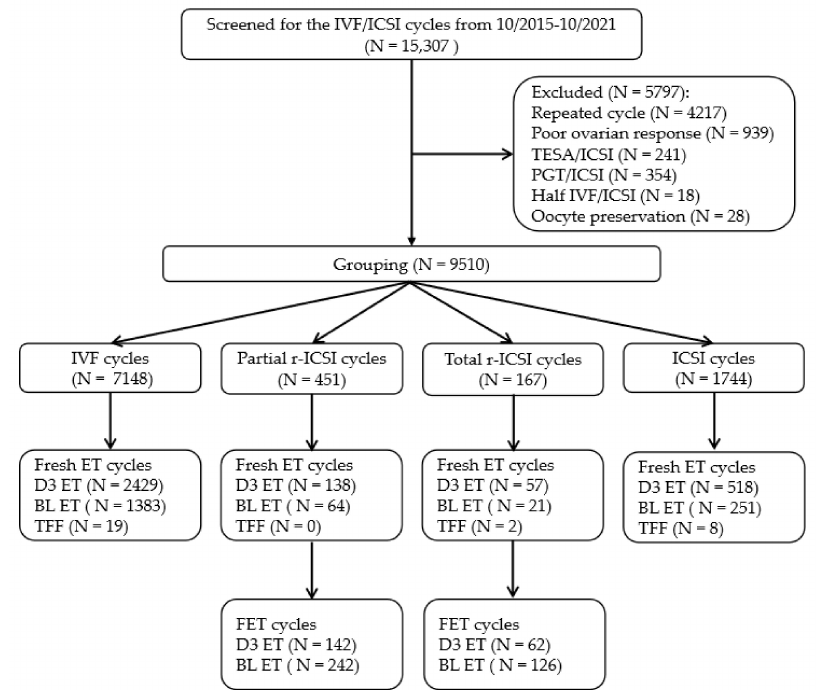
Figure 1. Cycles included in this study. IVF, in vitro fertilization; ICSI, intracytoplasmic sperm injection; TESA, testicular sperm aspiration; PGT, preimplantation genetic testing; ET, embryo transfer; FET, frozen-thawed embryo transfer; BL, blastocyst; TFF, total fertilization